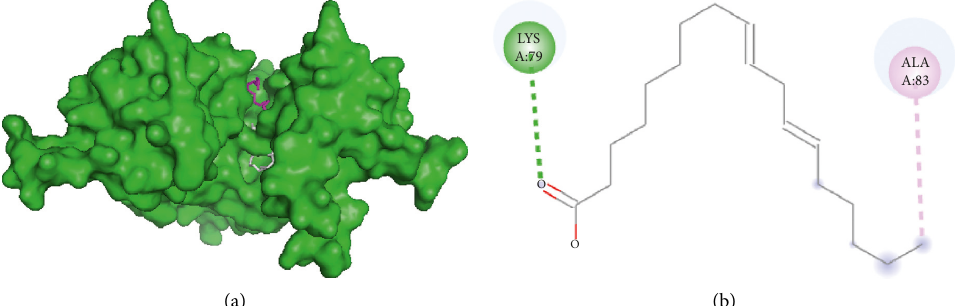
Figure 4: Interaction of linoleic and palmitic acids with filaggrin. (a) 3D visualization: linoleic acid (purple) and palmitic acid (grey). (b) 2D visualization: amino acid residues in linoleic acid and palmitic acid.